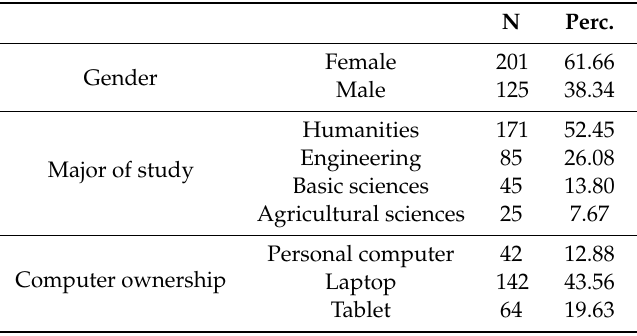
Table 3. Demographic characteristics of the participants.